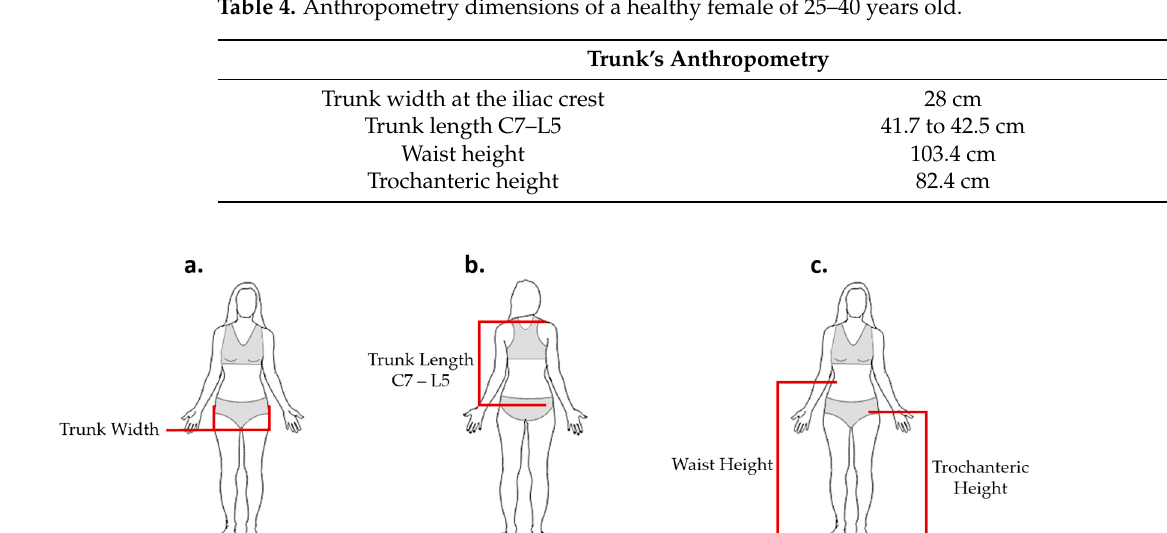
Table 4. Anthropometry dimensions of a healthy female of 25–40 years old.